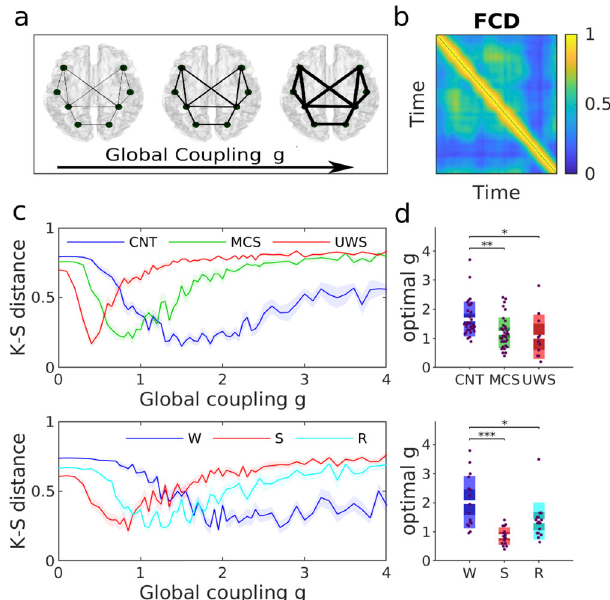
Fig. 2 Fitting of global coupling parameter in the whole-brain network model. a The global coupling model parameter g scales the weights of the SC matrix. Low and high values of g represent networks where the functional connectivity is weakly and strongly coupled to the structural networks, respectively. b To estimate this global parameter, we sought the model that best reproduced the distribution of FCD values ( fi xing all other model parameters). c KS-distance between the empirical and the model FCD distributions, as a function of g , for one participant of each subject group (top: healthy controls and DOC patients; bottom: awake and anaesthetized subjects). Solid lines and shaded areas represent the mean and the standard error of the fi tting curves over simulation trials. d Optimal global coupling g for all participants. In each panel, each dot represents a participant and the boxes represent the distribution of g . Boxplots represent the mean of the measures' values with a 95% con fi dence interval (dark) and 1 SD (light). Differences between groups were assessed using one-way ANOVA followed by FDR p-value correction. *: p <0.05; **: p < 0.01; ***: p < 0.001. In panels ( c ) and ( d ), we used the healthy structural connectivity as the underlying connectivity of all